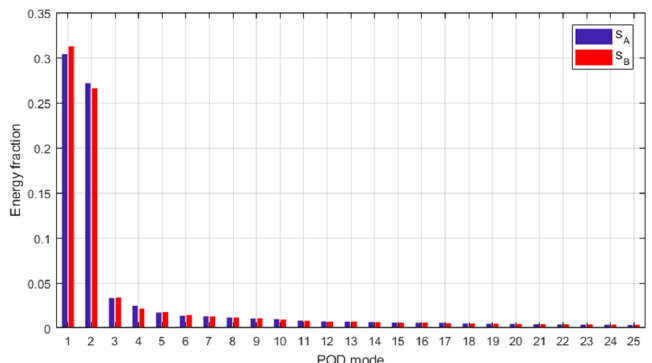
Figure 7. Comparison of energy fraction for each proper-orthogonal-decomposition (POD) mode of Set A and B. Curtailed at mode 25 for clarity.